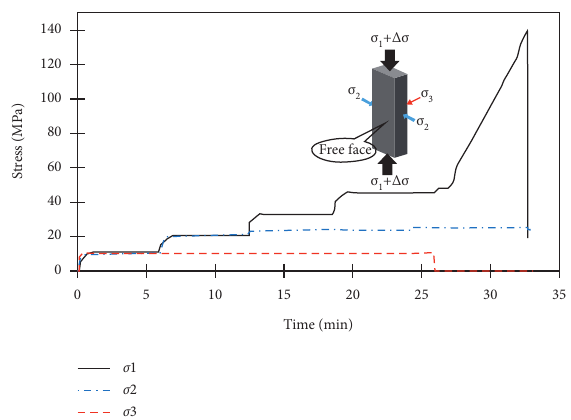
Figure 13: Stress path diagram of strain burst test under σ